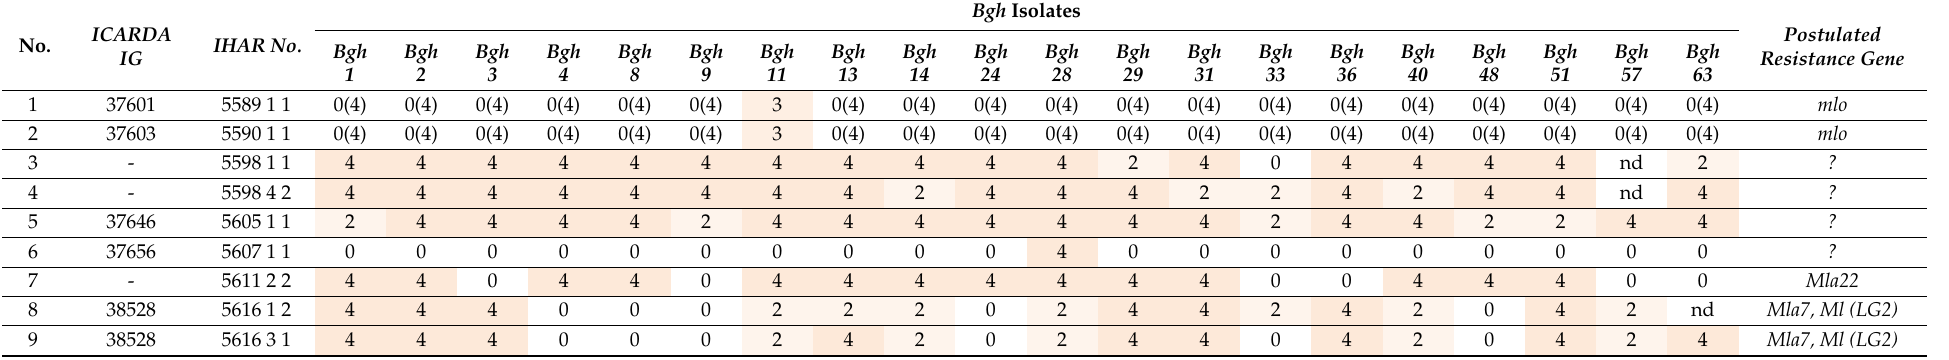
Table 3. Set of barley ( H. vulgare L.) landraces originated from Yemen, which revealed resistance to at least one B. graminis f. sp. Hordei isolate after inoculation at the seedling stage.